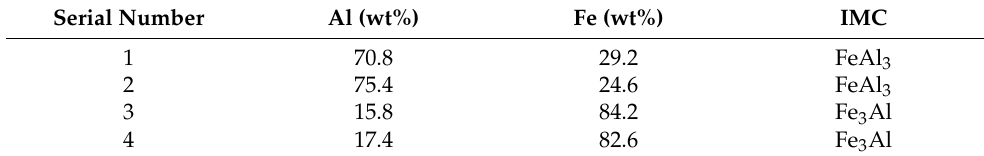
Table 3. The EDS results on the Al-Fe interface IMC, corresponding to the parameters of Table